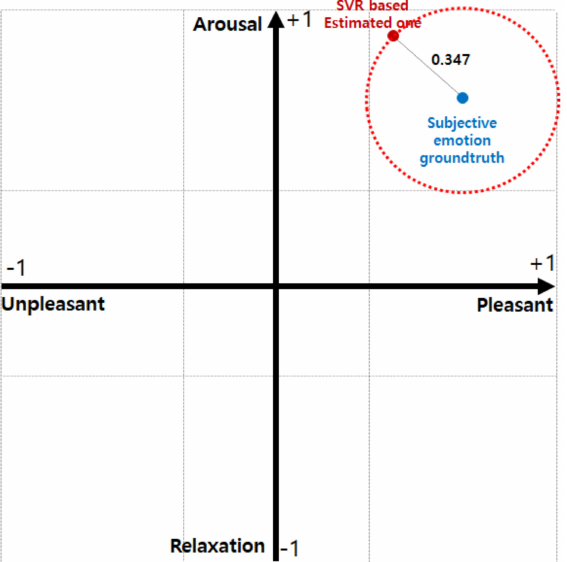
Figure 10. The distance of results between estimated emotion and subjective evaluation on the 2D emotional plane divided into a 3 × 3